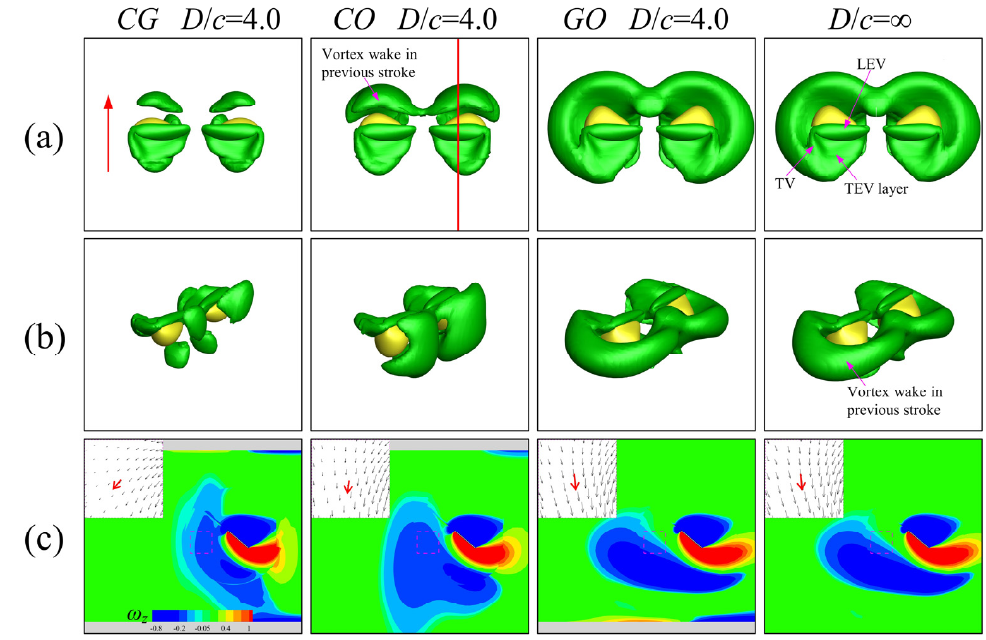
Figure 14. ( a ) Top view; ( b ) oblique view of the iso-Q surface (green) and iso-vertical velocity surface (yellow) showing the strength of downwash; and ( c ) spanwise vorticity distributions on a slice at τ = 0.25 for the combined ceiling and ground case (referred to as CG ), the ceiling-only case (referred to as CO ), the ground-only case (referred to as GO ) at D / c = 4.0 and D / c = ∞ case at Re = 10. The red arrow and red line in ( a ) give the stroke direction and the slice position, respectively.